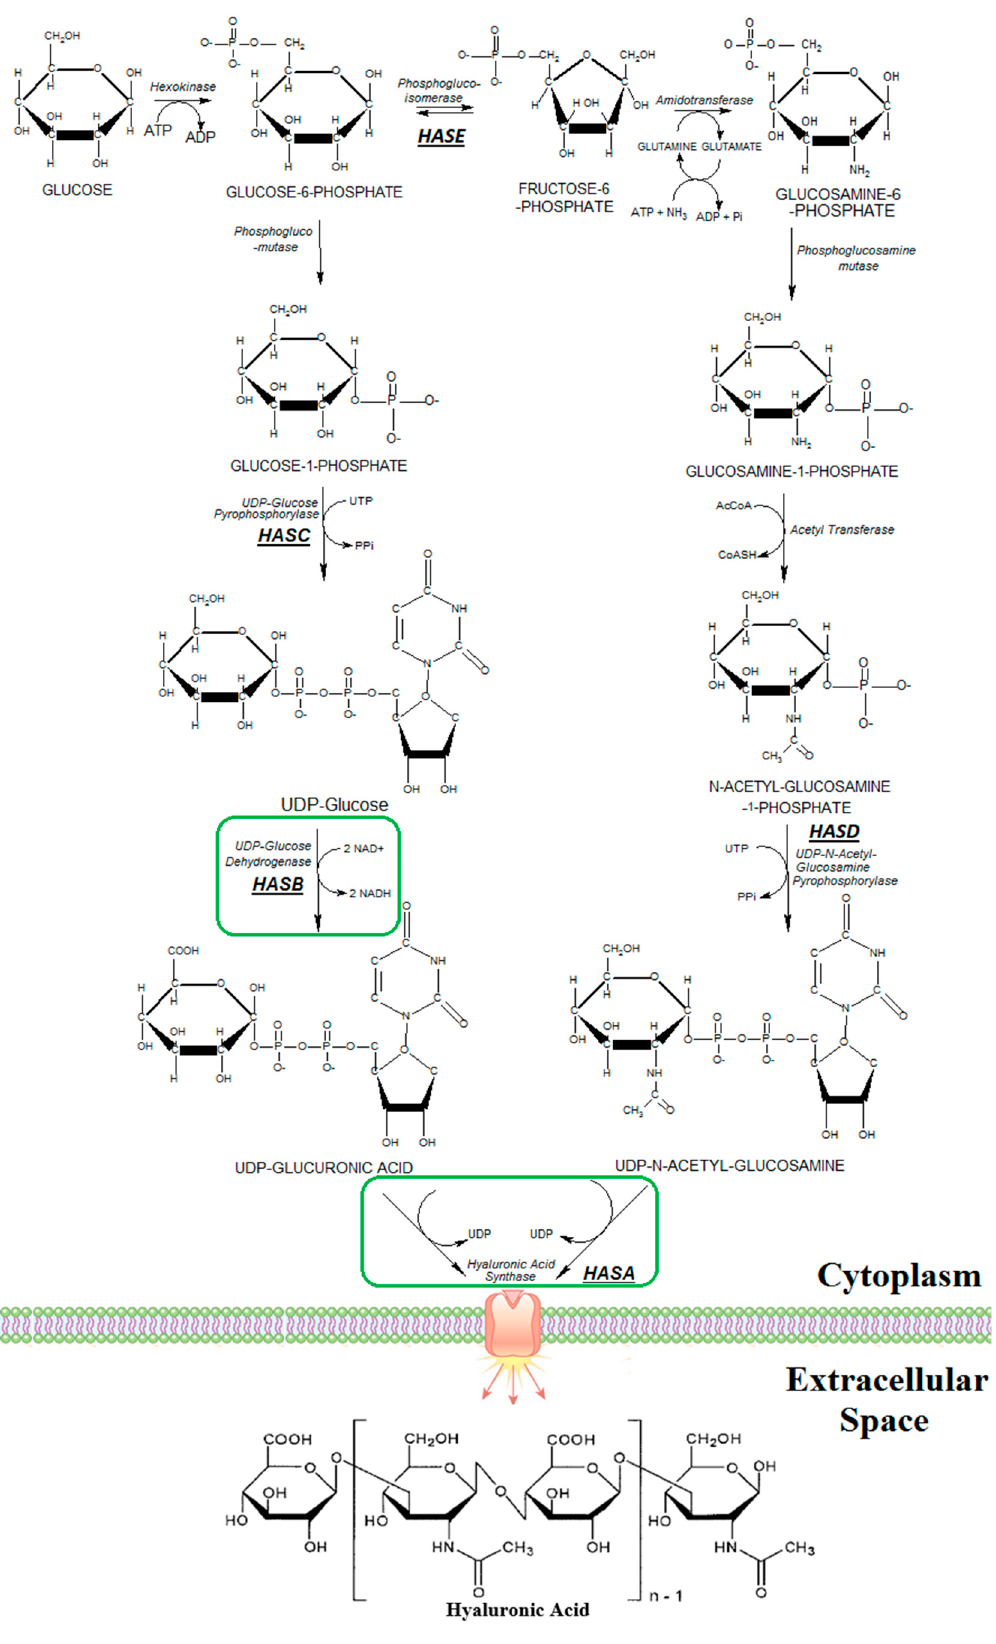
Figure 1. The metabolic pathway for Hyaluronic Acid production. In green, the enzymes that are not present in the metabolism of K. lactis but are necessary for the synthesis of Hyaluronic Acid.